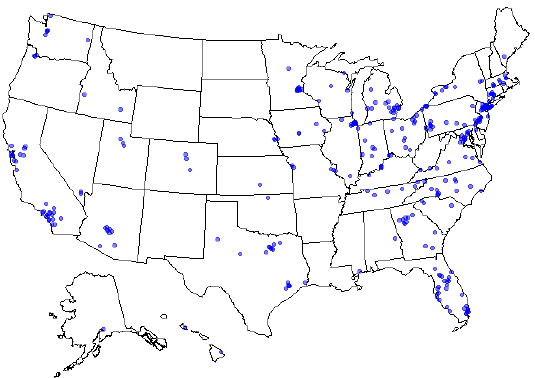
Figure 1. Geographic distribution of sample throughout the U.S.